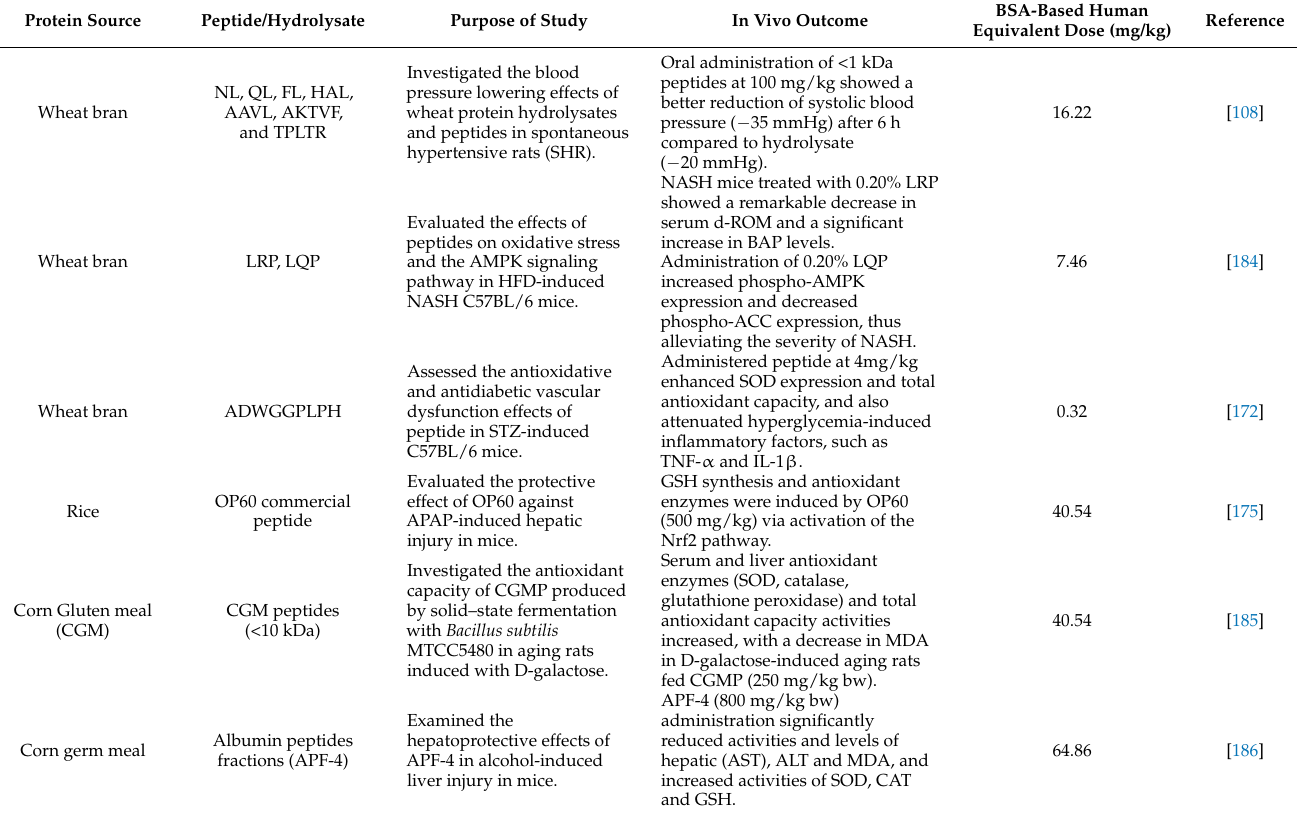
Table 7. Antioxidant effects of cereal-derived peptides and hydrolysates in animal